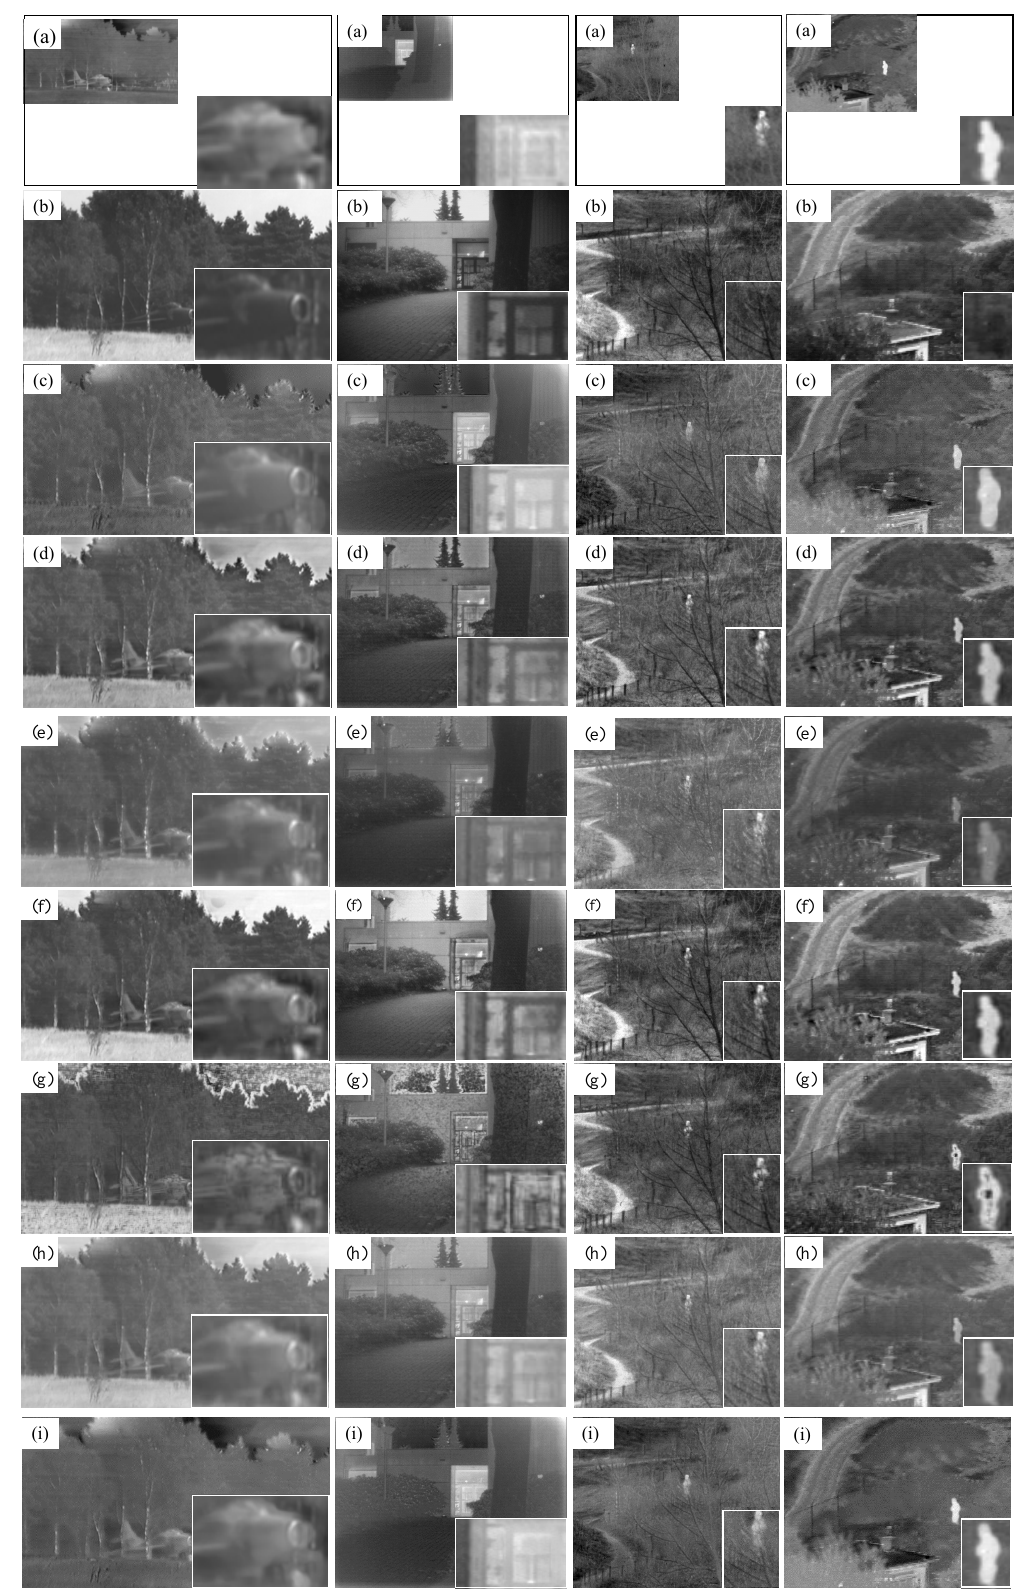
Figure 2. Fusion results of different fusion methods on four image pairs. The four groups of results from left to right: airplane_in_trees , Kaptein_01 , nato_camp_sequence and sandpath , where the corresponding subfigures are: ( a ) infrared image; ( b ) visible image; ( c ) our DRTV; ( d ) LP [43]; ( e ) RP [44]; ( f ) HMSD [26]; ( g ) CBF [45]; ( h ) DDCTPCA [46]; ( i ) GTF